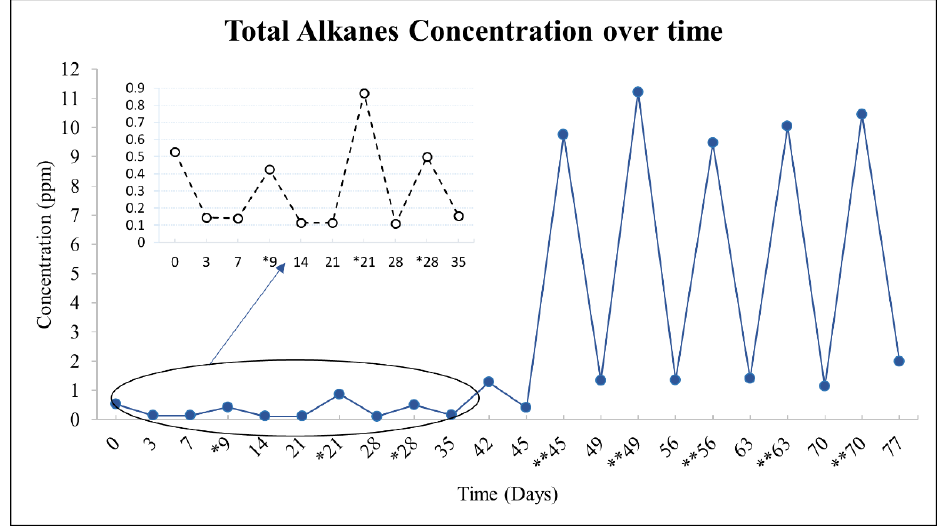
Figure 5. Concentration of the total GC-MS detected alkanes over the course of the experiment. * denotes the addition of oil and ** denotes the addition of oil and dispersant. The measured polycyclic aromatic hydrocarbons (PAHs) concentrations were, as expected, lower than the alkanes. The concentrations of PAHs in the OIL treatment seem to stay constant at 61 ppb, without showing any significant decrease. For the OIL + D treatment (day 42 and thereafter), PAH concentrations after each replenishment were about 100 times higher than the corresponding ones in the OIL treatment (~1.2 ppm after the addition of the dispersed oil). The concentration of PAHs for the two treatments are shown in Figure 6.